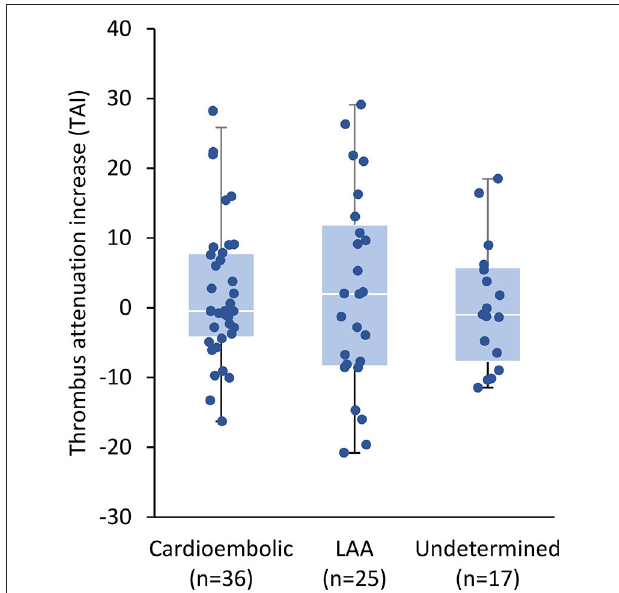
FIGURE 3 | Boxplot of thrombus attenuation increase (TAI) assessed on baseline computed tomography imaging according to stroke etiology. The group “stroke of other determined etiology” only comprised two patients and is not shown in the chart. TAI did not vary significantly between groups ( p = 0.955). The white lines within the boxes correspond to the distributions’ median, the blue areas encompass values between the first and third quartiles, and the upper and lower whiskers extend to a maximum length of 1.5 times the interquartile range. LAA indicates large artery